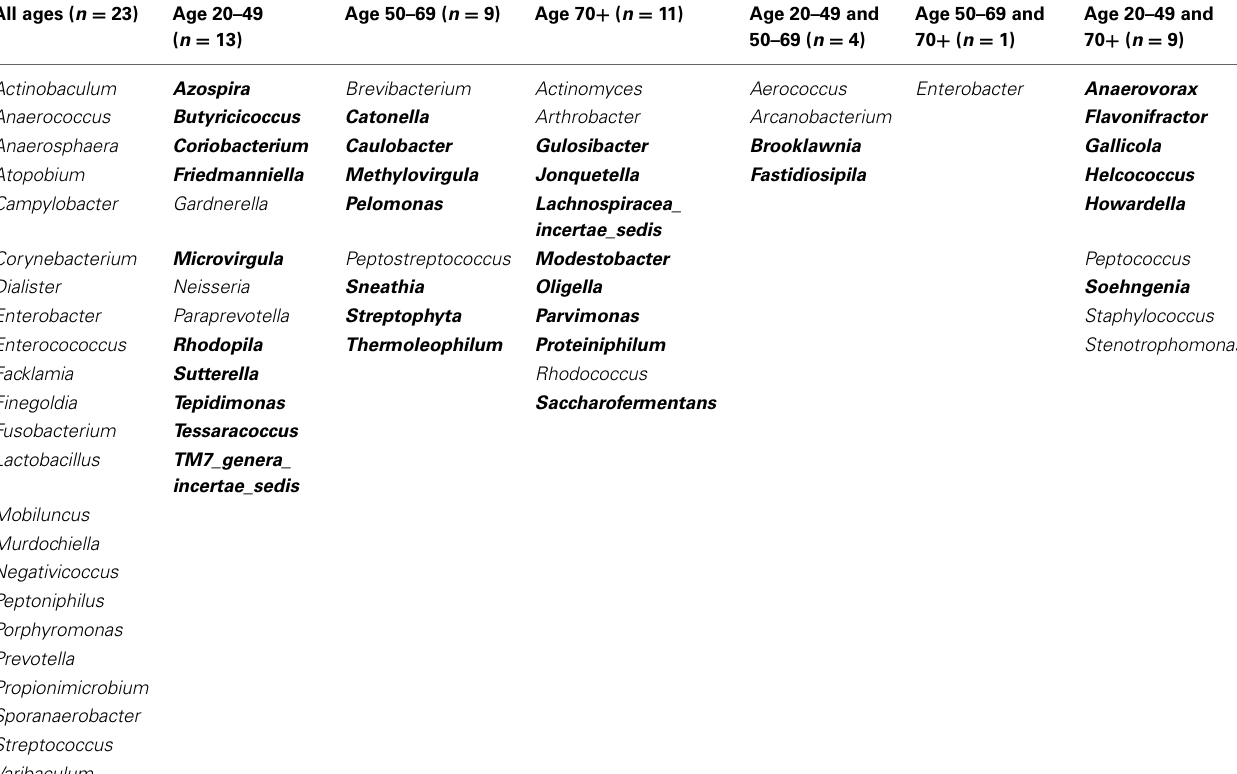
Table 2 | Table detailing the genera identified within each defined age group for females only. All ages ( n =